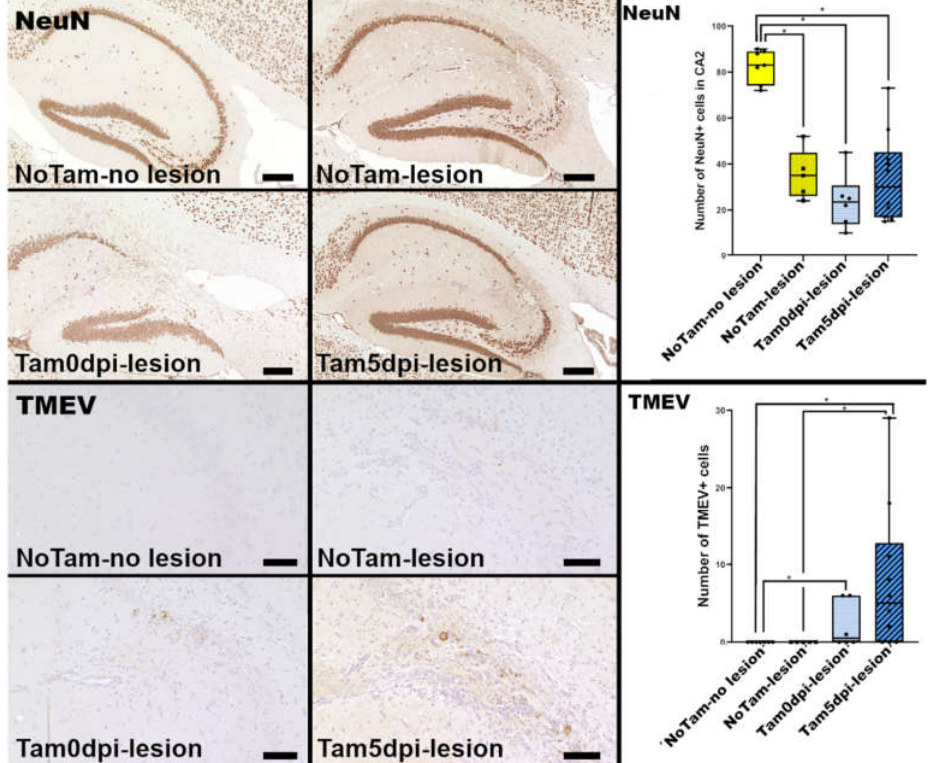
Figure 1. Immunohistochemical evaluation of hippocampi of Theiler’s murine encephalomyelitis virus BeAn (TMEV-BeAn) infected mice 14 days post-infection (dpi) and representative images of each marker, depicting the most prominent findings and statistical analysis of the obtained data on the right. Mice without tamoxifen treatment were separated into two groups; animals with no lesions (NoTam—no lesions) and mice with hippocampal neuronal loss (NoTam—lesions), and mice with tamoxifen treatment 0, 2 and 4 dpi (Tam0dpi—lesion) and mice with tamoxifen treatment 5, 7 and 9 dpi (Tam5dp—lesion). The graphs depict the groups as follows: NoTam—no lesions: yellow, no filling, NoTam—lesions: yellow/V-pattern, Tam0dpi—lesion: light blue/dotted and Tam5dpi—lesion: blue/striped. Tamoxifen-treated animals showed a more frequent occurrence of neuronal loss, consisting of fewer neuron nuclear antigen (NeuN) positive neurons in the cornu ammonis region 2 (CA2) of the hippocampus. Mice without tamoxifen application eliminatedTMEV from the hippocampus within 14 days, while 10 of 16 tamoxifen-treated animals (63%) still showed intralesional TMEV antigen in the hippocampus at this time point. Scale bars: 200 µ m (NeuN) and 50 µ m (TMEV). Statistical significant differences are depicted as * = p ≤ 0.05 (Supplementary Table S1 for each p -value